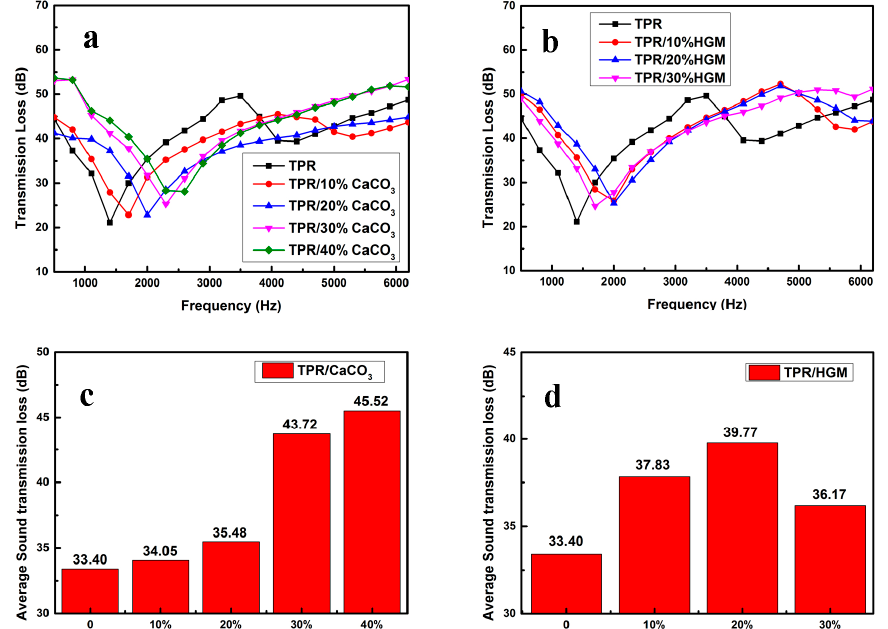
Figure 3. Sound insulation property of neat TPR and its composites: The STL (sound transmission loss) curves versus the sound frequency of ( a ) TPR/CaCO 3 composites and ( b ) TPR/HGM composites; the average STL value of ( c ) TPR/CaCO 3 composites and ( d ) TPR/HGM composites.